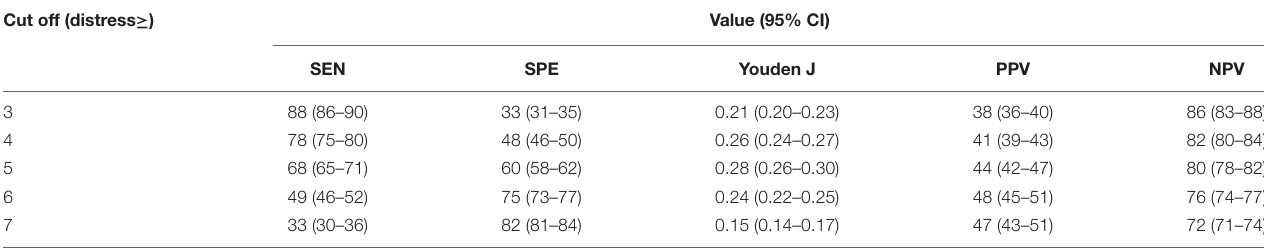
TABLE 3 | Diagnostic properties of the DT for detection of MD *, **.